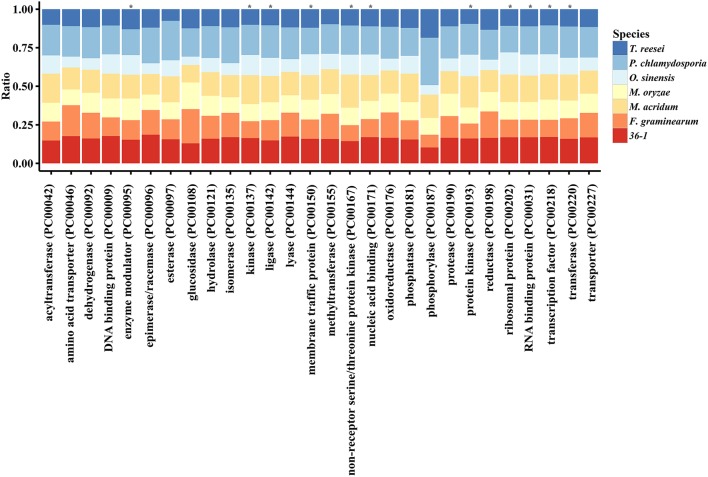
Comparison of gene families between different fungi. *:Indicates significantly expansion of P. lilacinum 36-1 relative to O. sinensis (P < 0.05); Protein class indicates the classification system by PANTHER. Ratio indicates the percentage of protein class in different fungi.